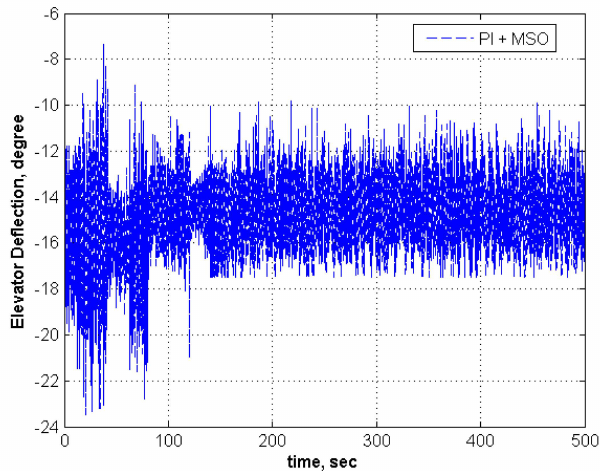
Figure 7. Elevator deflection for 100% C m α .